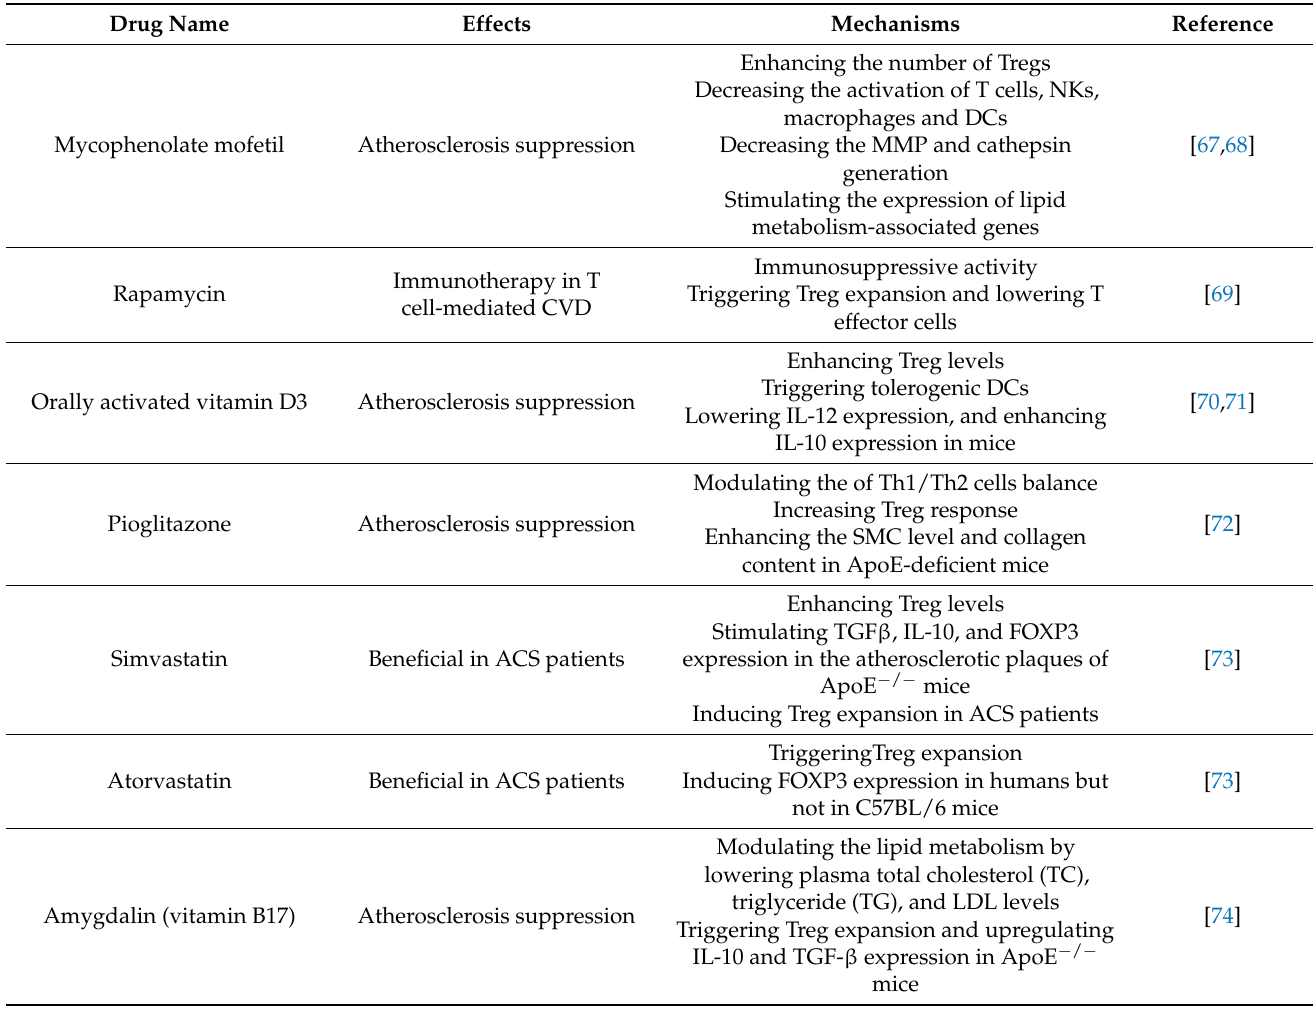
Table 1. Effects of several well-known drugs on